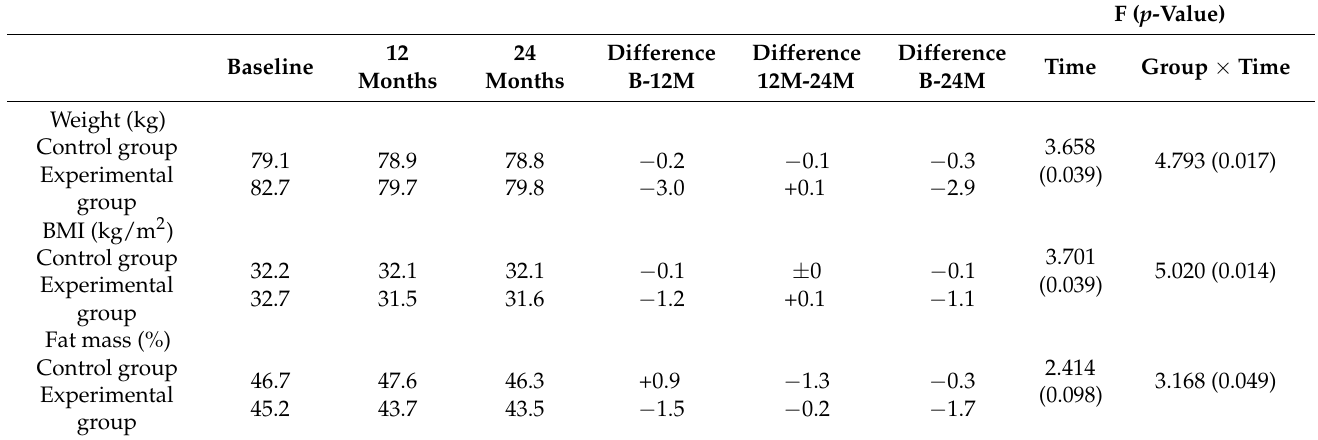
Table 3. Changes in weight, BMI, and %FM in each of the